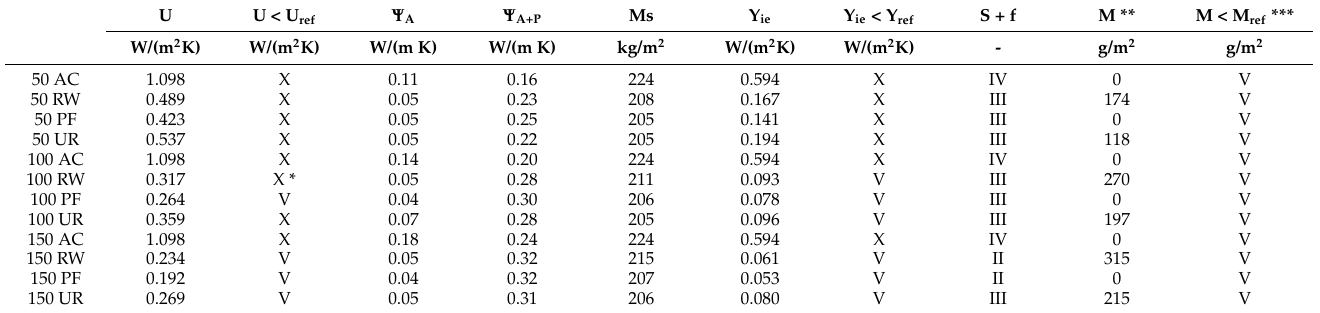
Table 8. Summary of the main results—cavity insulation and internal plaster substitution.